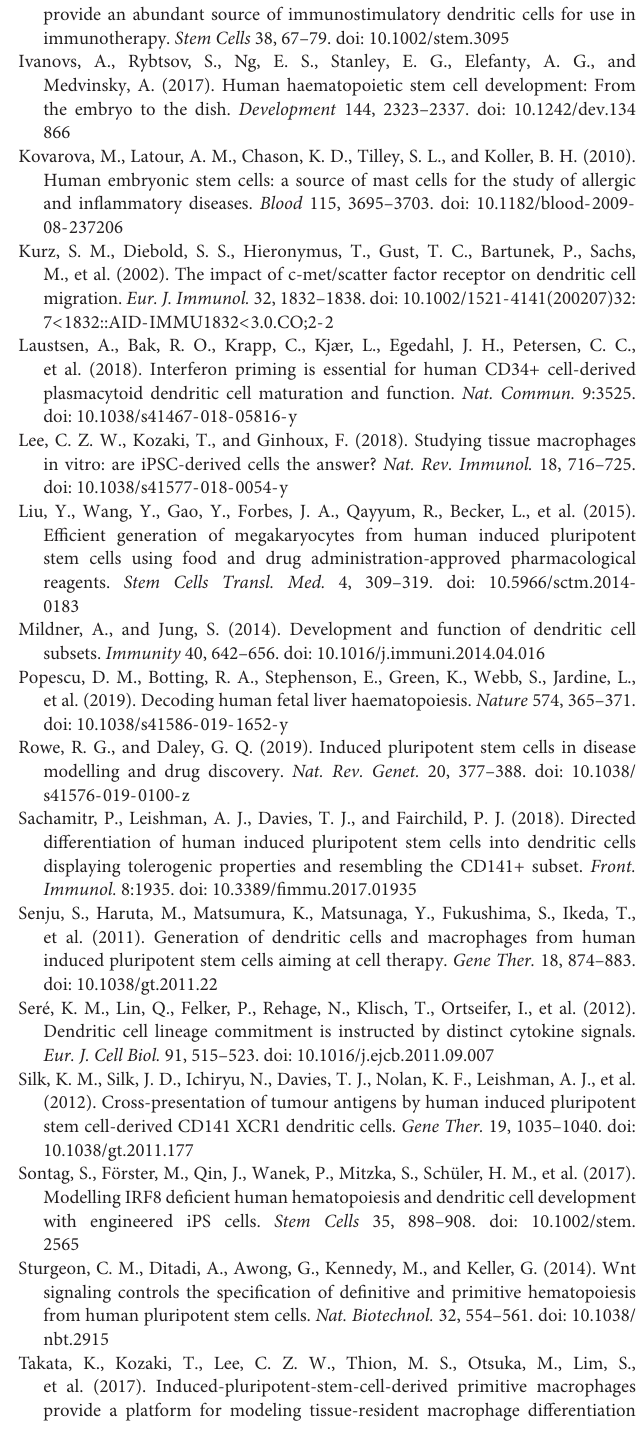
Supplementary Figure 4C determined by RT-qPCR analysis. Values were normalized to GAPDH and 2 − (cid:49) Ct values were shown. n = 3, mean ± SD; ∗ p < 0.05, ∗∗ p < 0.005, one-way ANOVA with uncorrected fisher’s LSD test between unstimulated and LPS-stimulated cells for the various JAK2 V617F genotypes as